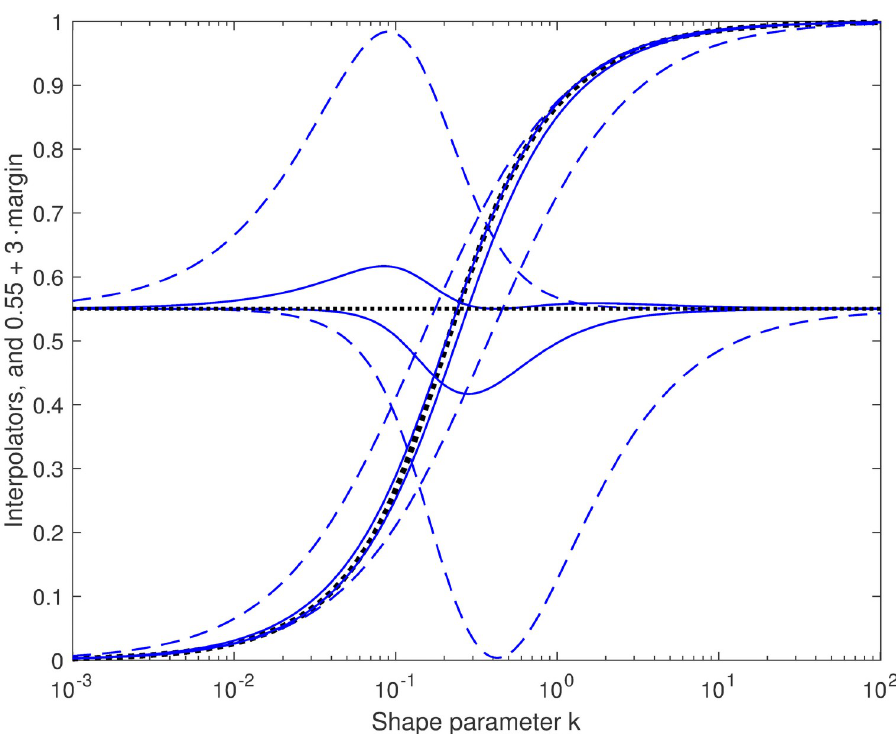
Fig 8. Bounding the ideal interpolator function. The ideal interpolator g ( k ) (heavy dotted sigmoid) is compared with upper and lower bounds ~ g ð k Þ ; their margins ~ g ð k Þ (cid:0) g ð k Þ are also plotted, magnified and displaced, with the same curve styles. The curves with largest absolute margins (dashed), which correspond to the interpolated bounds shown in Fig 6, are for the first-order rational-function interpolator k , while the curves with smaller margins (solid) are for k þ b 0 arctan interpolators 2 . In each case, the one parameter ( b 0 or b ) is chosen to give a tight bound (analytically in tan (cid:0) 1 k p b closed form in three of the four cases). Lower bounds of g ( k ) make upper bounds of ν ( k ), and vice versa.